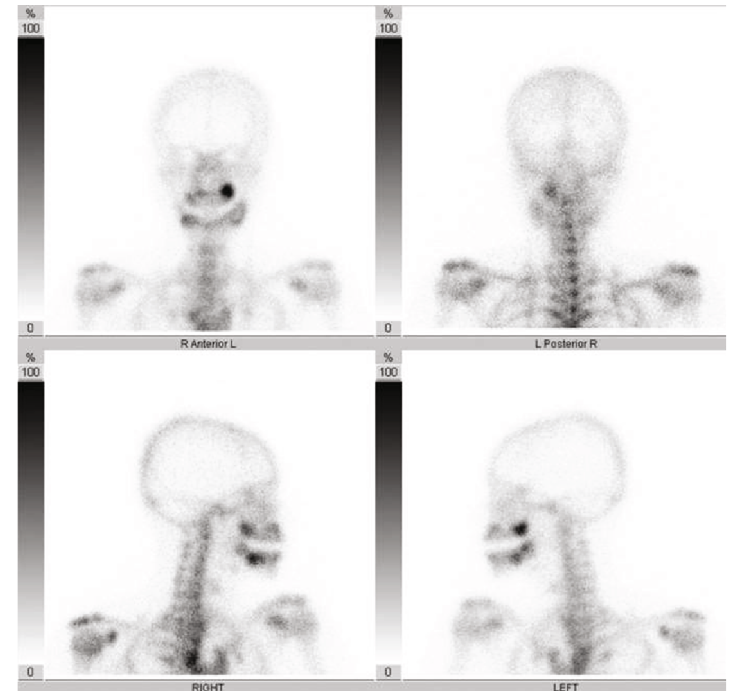
Figure 4: Bone scintigram. Tracer accumulations are observed in the high-density lesion on CT fi nding of the mandible and maxilla.